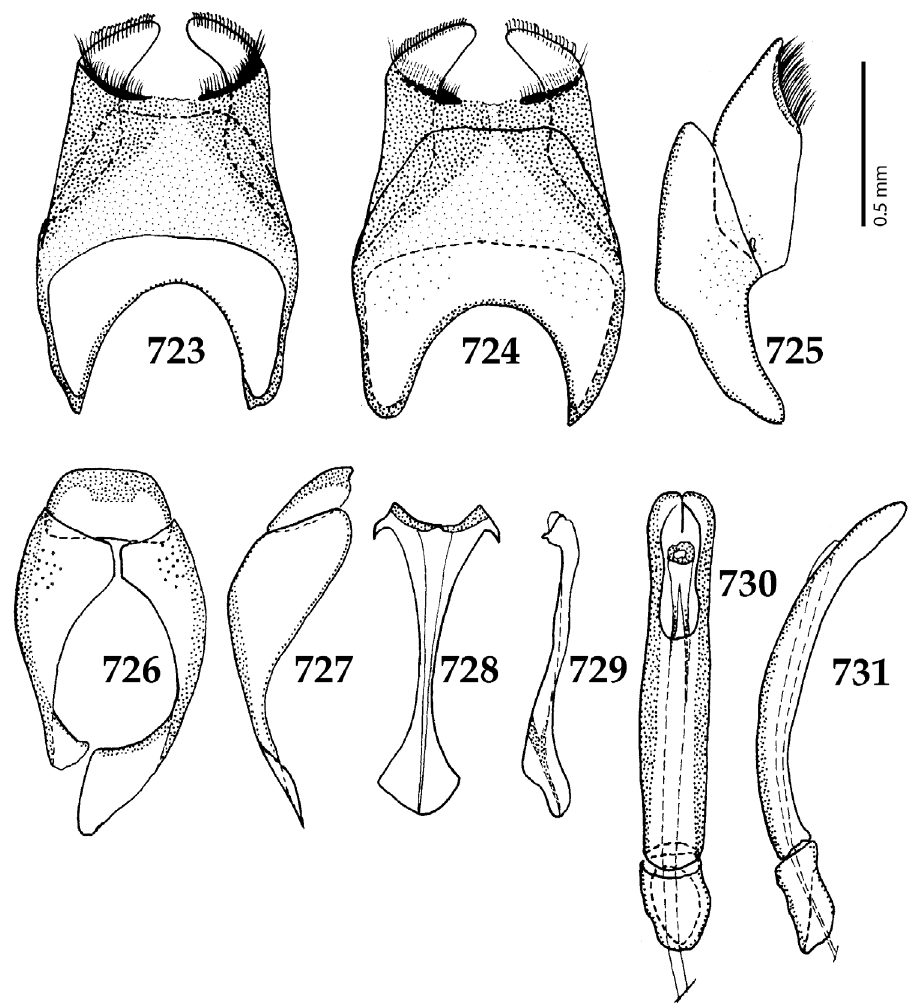
Figures 723–731. 723 Tomogenius papuaensis Gomy, 2007 male terminalia: 8 th sternite + 8 th tergite, ventral view 724 ditto, dorsal view 725 ditto, lateral view 726 male terminalia: 9 th + 10 th tergites, dorsal view 727 ditto, lateral view 728 male terminalia: spiculum gastrale, ventral view 729 ditto, lateral view 730 male terminalia: aedeagus, dorsal view 731 ditto, lateral